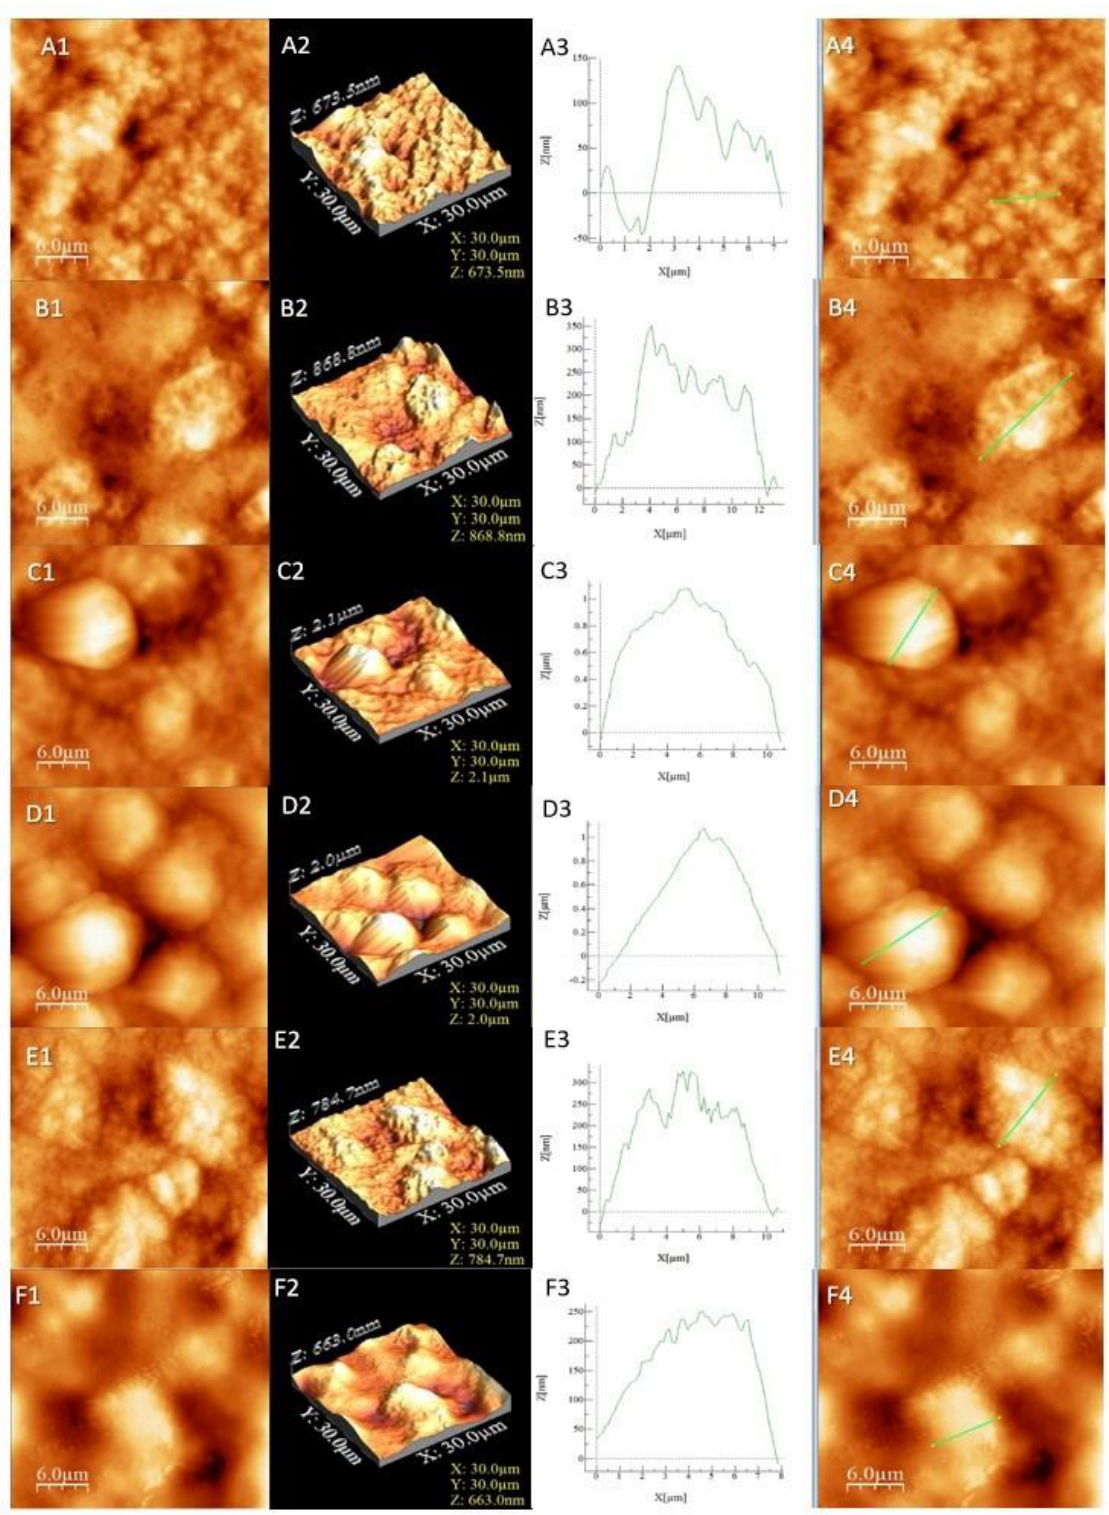
Figure 2. AFM images for the studied liposomes. The letters correspond to ( A ) L1, ( B ) L2, ( C ) L3, ( D ) L4, ( E ) L5 and ( F ) L6. The numbers correspond to ( 1 ) AFM image, ( 2 ) 3D image, ( 3 ) profile of the sample and ( 4 ) area selected for profiling.